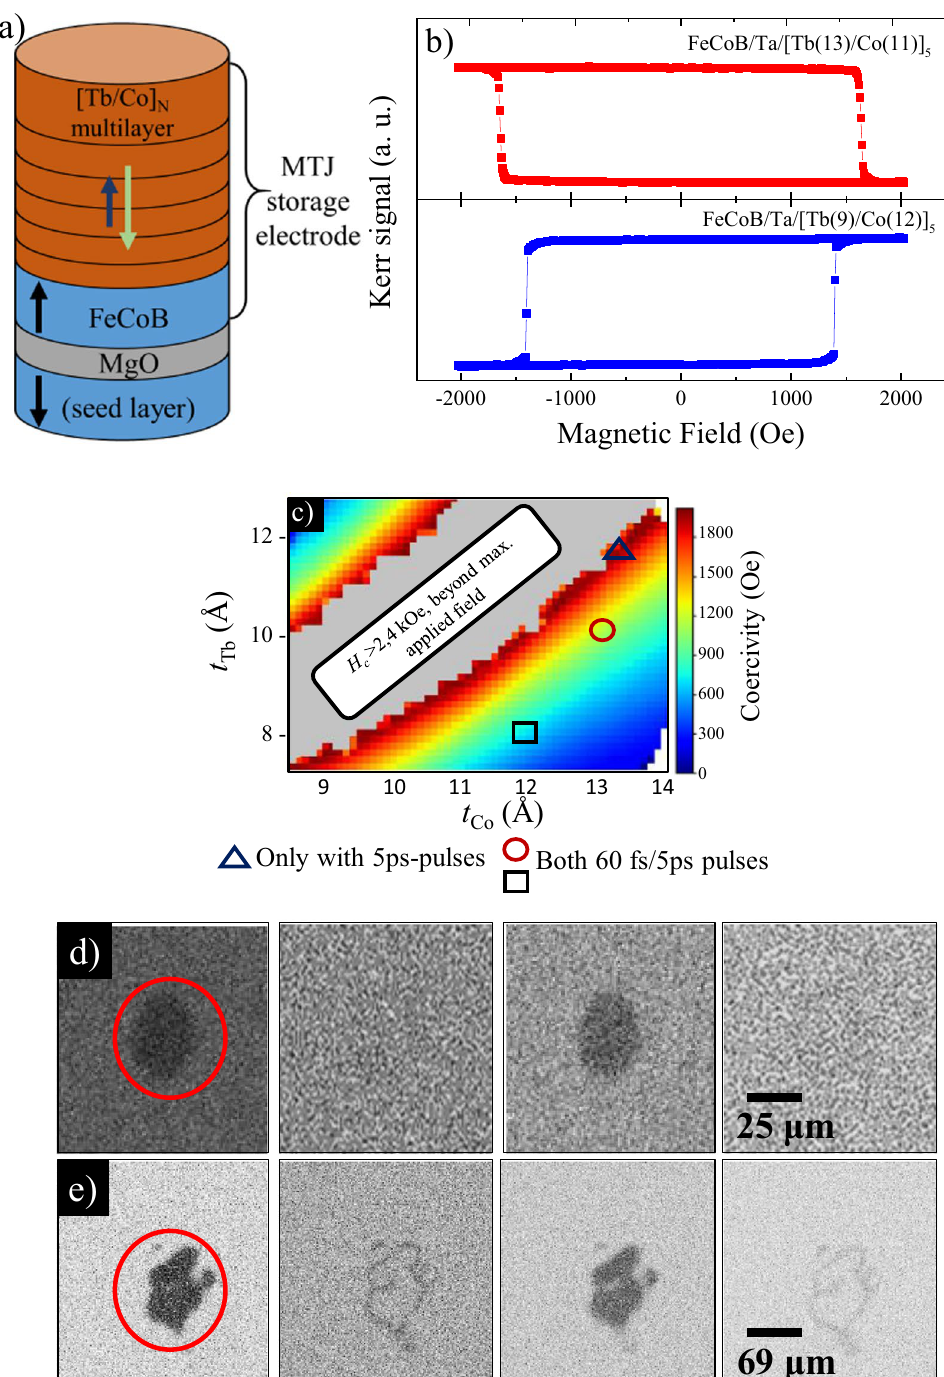
Figure 3. ( a ) Structure of half-MTJ stack used to optimize the magnetic coupling between the [Tb(10 Å )/ Co(12 Å )] 5 multilayer and the CoFeB electrode. ( b ) Hysteresis loop of the CoFeB/Ta/[Tb( t Tb )/Co( t Co )] 5 stack measured on opposite sides of the compensation region. ( c ) Coercivity map of the half-MTJ along the Tb and Co thickness wedges. The regions enclosed by the symbols indicate the three regions of the CoFeB/Ta/[Tb( t Tb )/ Co( t Co )] 5 structure in which all-optical switching was achieved using different pulse durations: ▵ : [Tb(11 Å )/